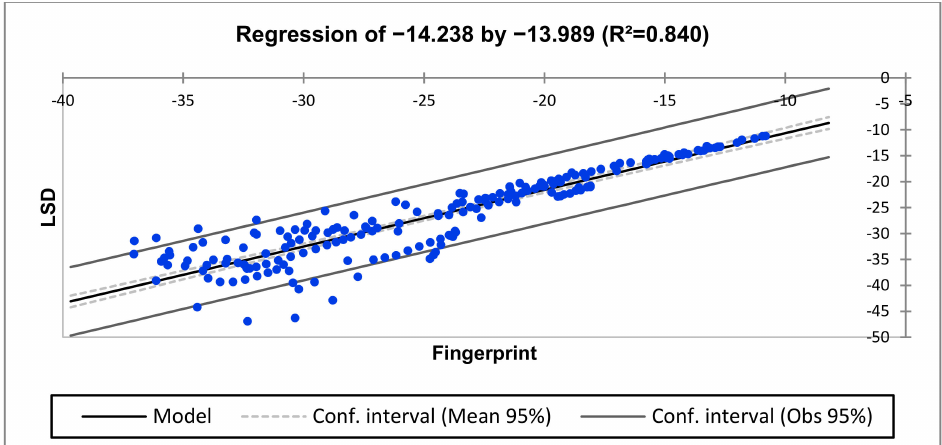
Figure 20. Regression for H2-H1 vs. H3-H2 (high-frequency region). Equation of the model: LSD = 0.465 + 1.021 × Fingerprint Equation of the model: LSD = − 5.834 × 10 − 2 + 1.017 × Fingerprint Equation of the model: LSD = 0.281 + 1.093 ×